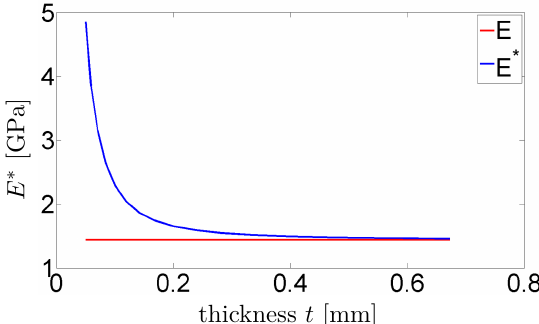
Figure 9. Size effect for decreasing thicknesses The sensitivity of the implemented numerical model of the modified second gradient continuum was tested for incorporation of size effect by decreasing the thick- ness values, while all other dimensions were scaled in parallel according to Tab. 1 . The solution of the tip deflection was used in a calculation of an equivalent Young ’s modulus, E ∗ , with a Euler-Bernoulli analytical beam model of the conventional Cauchy continuum. As plotted in Fig. 9, a size effect is clearly present. For small thicknesses the equivalent Young ’s modulus is calculated to be about three times larger than the usual